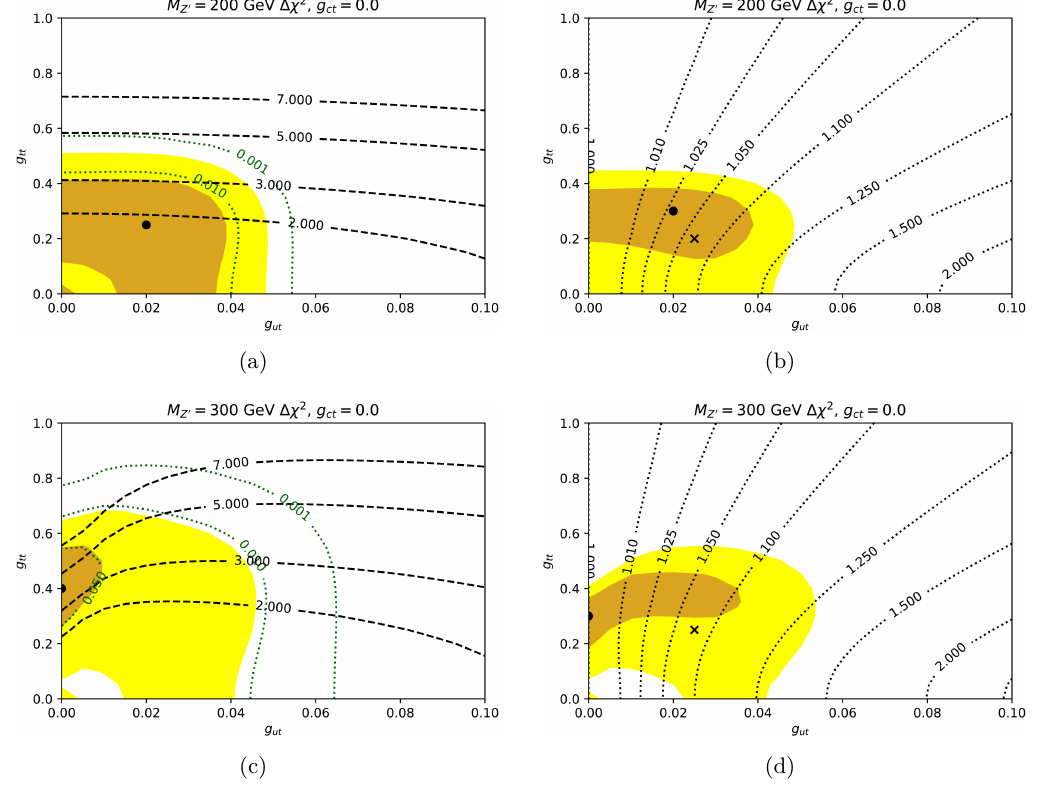
Figure 3 . Fits to data for M Z 0 < 2 m t in the ( g ut , g tt ) plane. Left column: ellipses correspond to 1 s.d. and 2 s.d. from the ttH NLL minima with the green dotted curve being the goodness-of-fit and the black dashed curve corresponding to N four-tops . Right column: ellipses correspond /N four-tops SM+BSM SM to 1 s.d. and 2 s.d. from the ttH + four-top-quarks NLL minima with the black dotted curve corresponding to the charge imbalance ratio of yields r (4 t ) defined in eq. 3.2. The ttH +